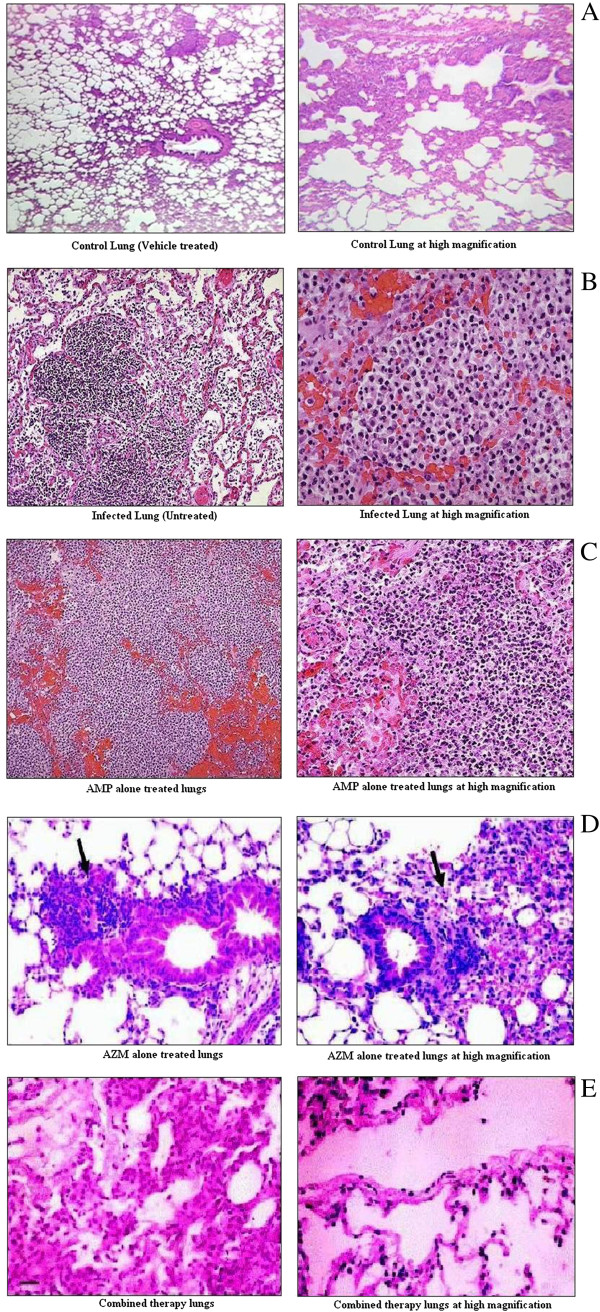
Histology of lung tissue in normal mice (A); S. pneumoniae infected mice (B); treated with antibiotics ampicillin (AMP) (C) and/or azithromycin (AZM) (D) either alone or in combination (E) 18 hours post infection. Pictures were taken from 0 – 6 hours after initiation of therapy which corresponds to 18 – 24 hours post infection. Profuse neutrophil count, diffuse edema with swelling of interstitium was noted in untreated infected animals, while mice receiving combination therapy recovered very fast than monotherapy and had tissue profiles similar to those of healthy controls. Left panel shows histology of lung tissue at low magnification and right panel at high magnification. Arrow indicates accumulation of PMNs in the alveoli.